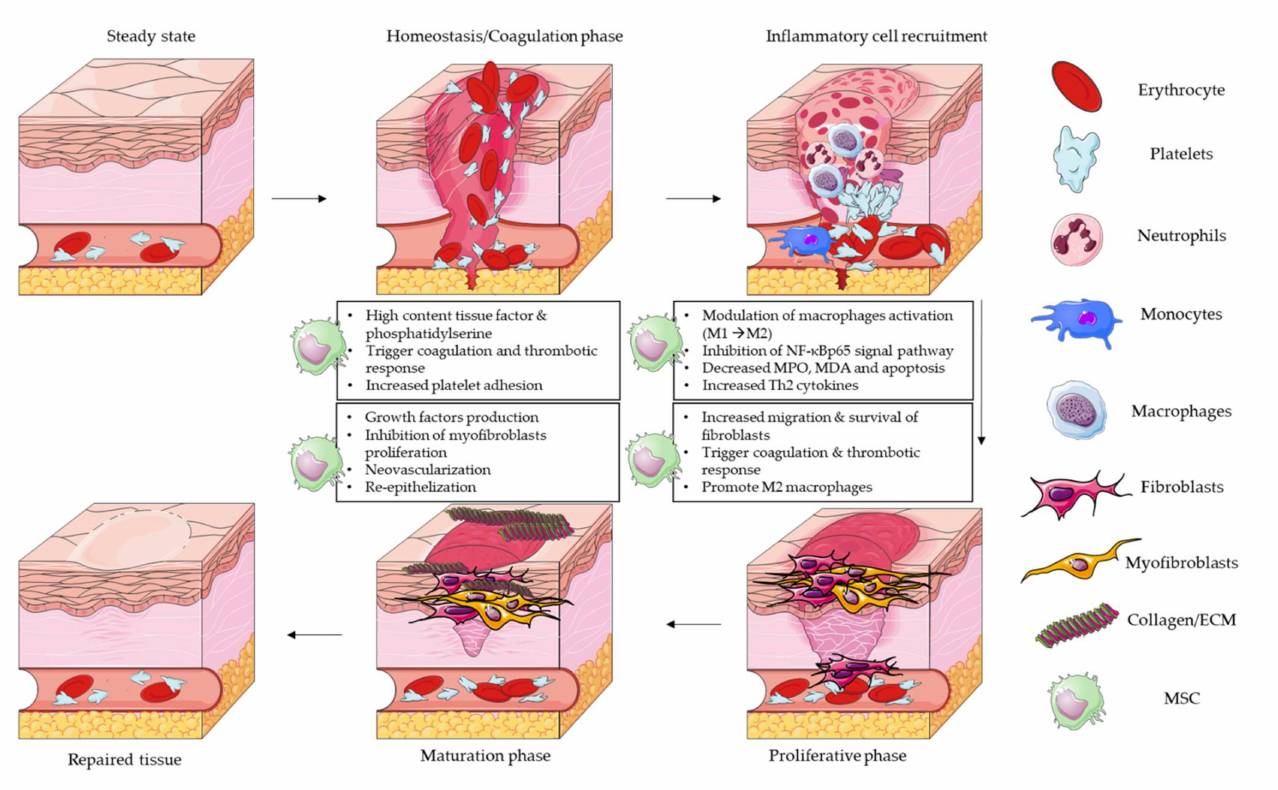
Figure 2. Wound healing process and role of mesenchymal stem/stromal cells in each step of the process. The illustration shows the cellular players in each phase and summarize the main functions of MSCs in each step. (MSC: mesenchymal stem cell; ECM: extracellular matrix; MPO: myeloperoxidase; MDA: